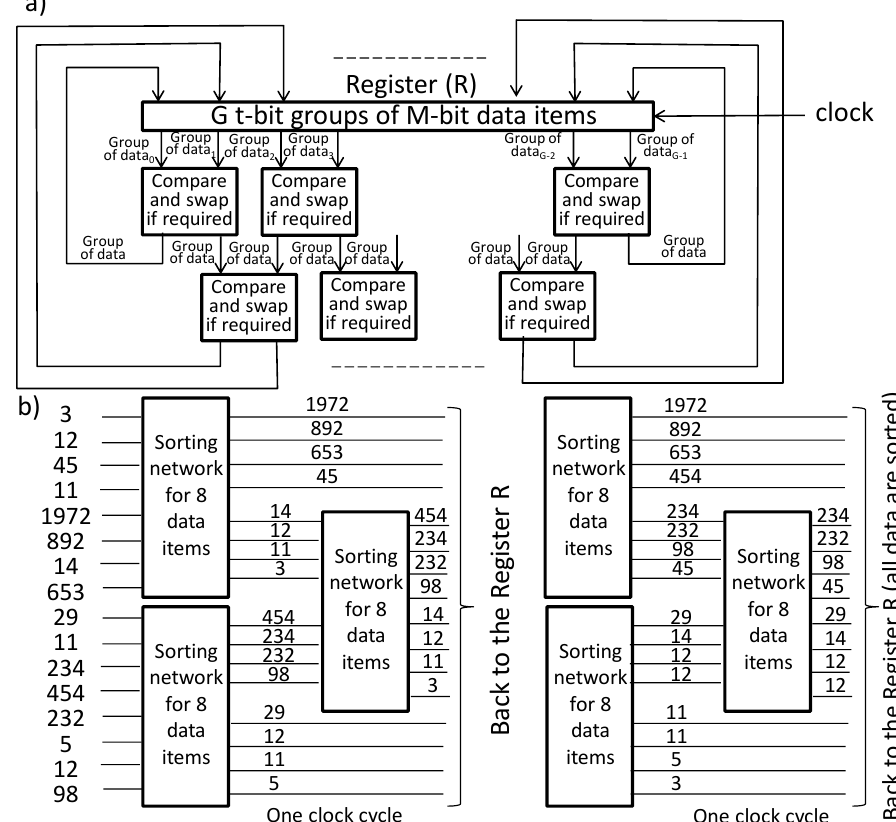
Fig. 8. Using sorting networks instead of comparators (a); an example of sorting (b).